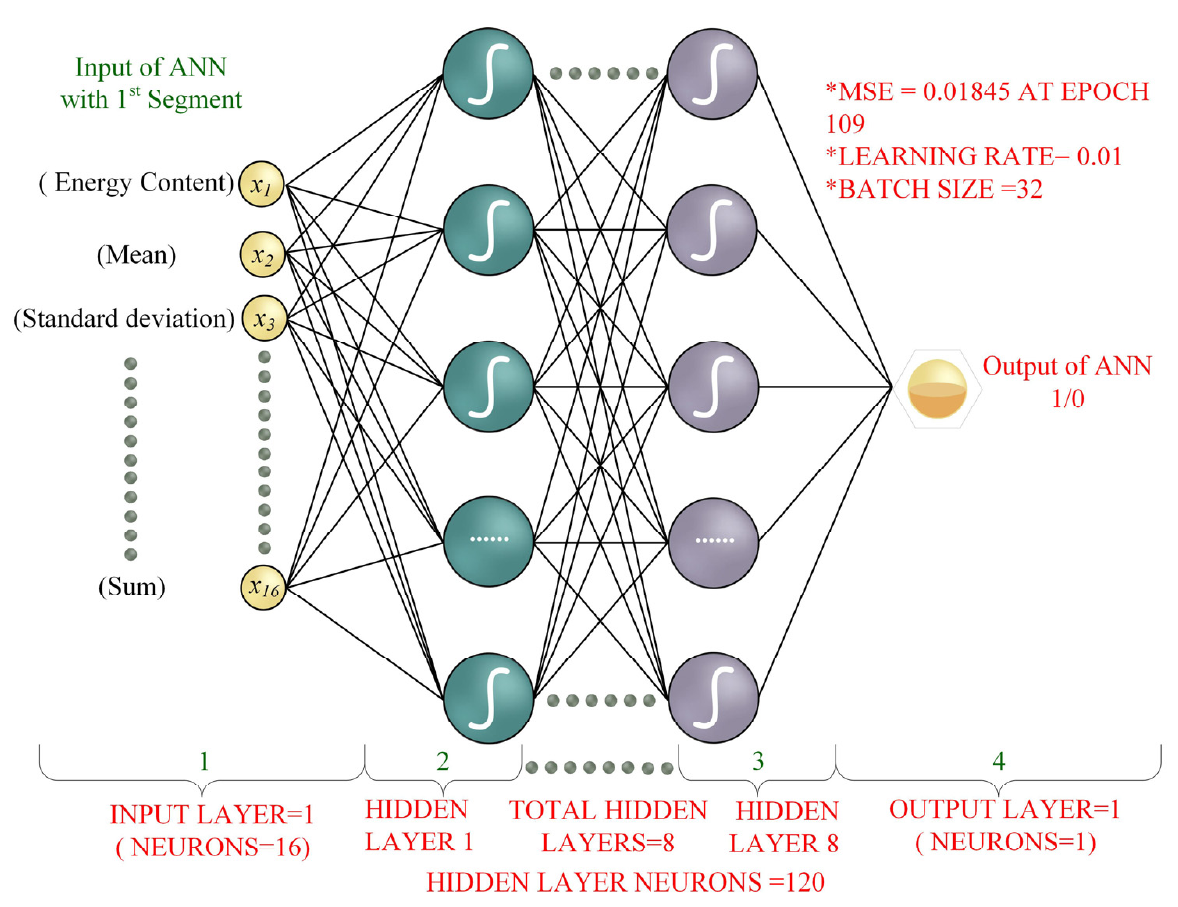
Figure 7. ANN classifier architecture.